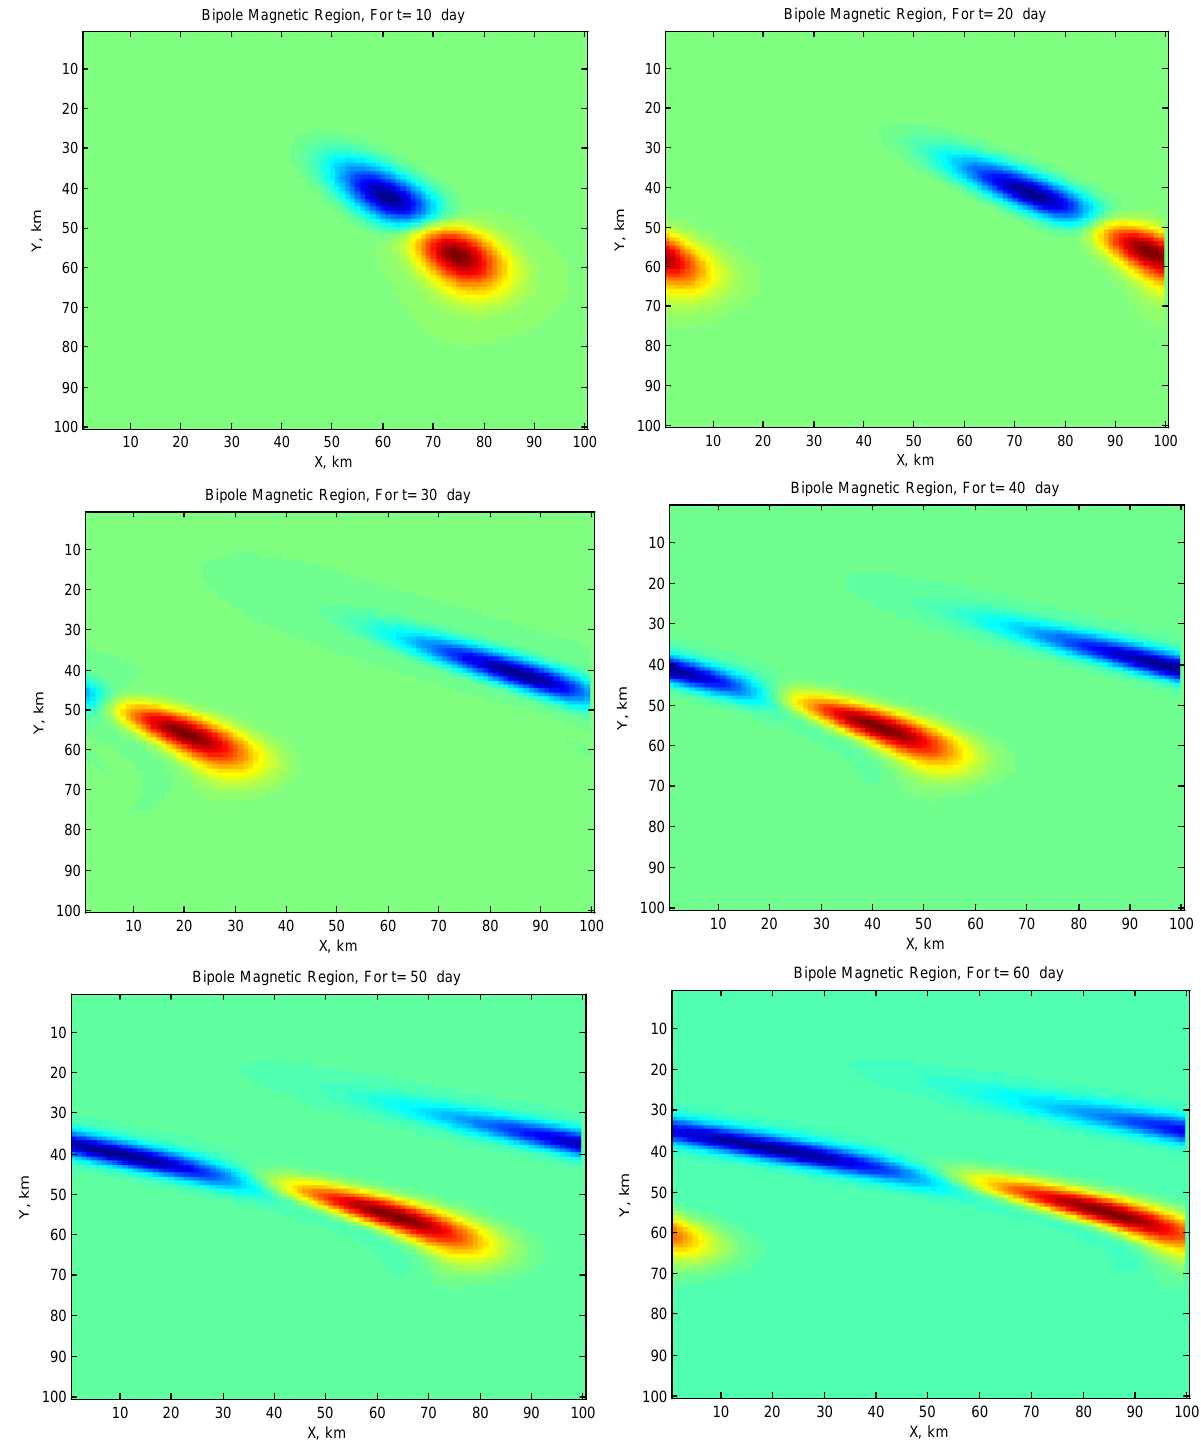
Fig. 6: Explicit numerical solution of equation of magnetic transport flux for 60 days and